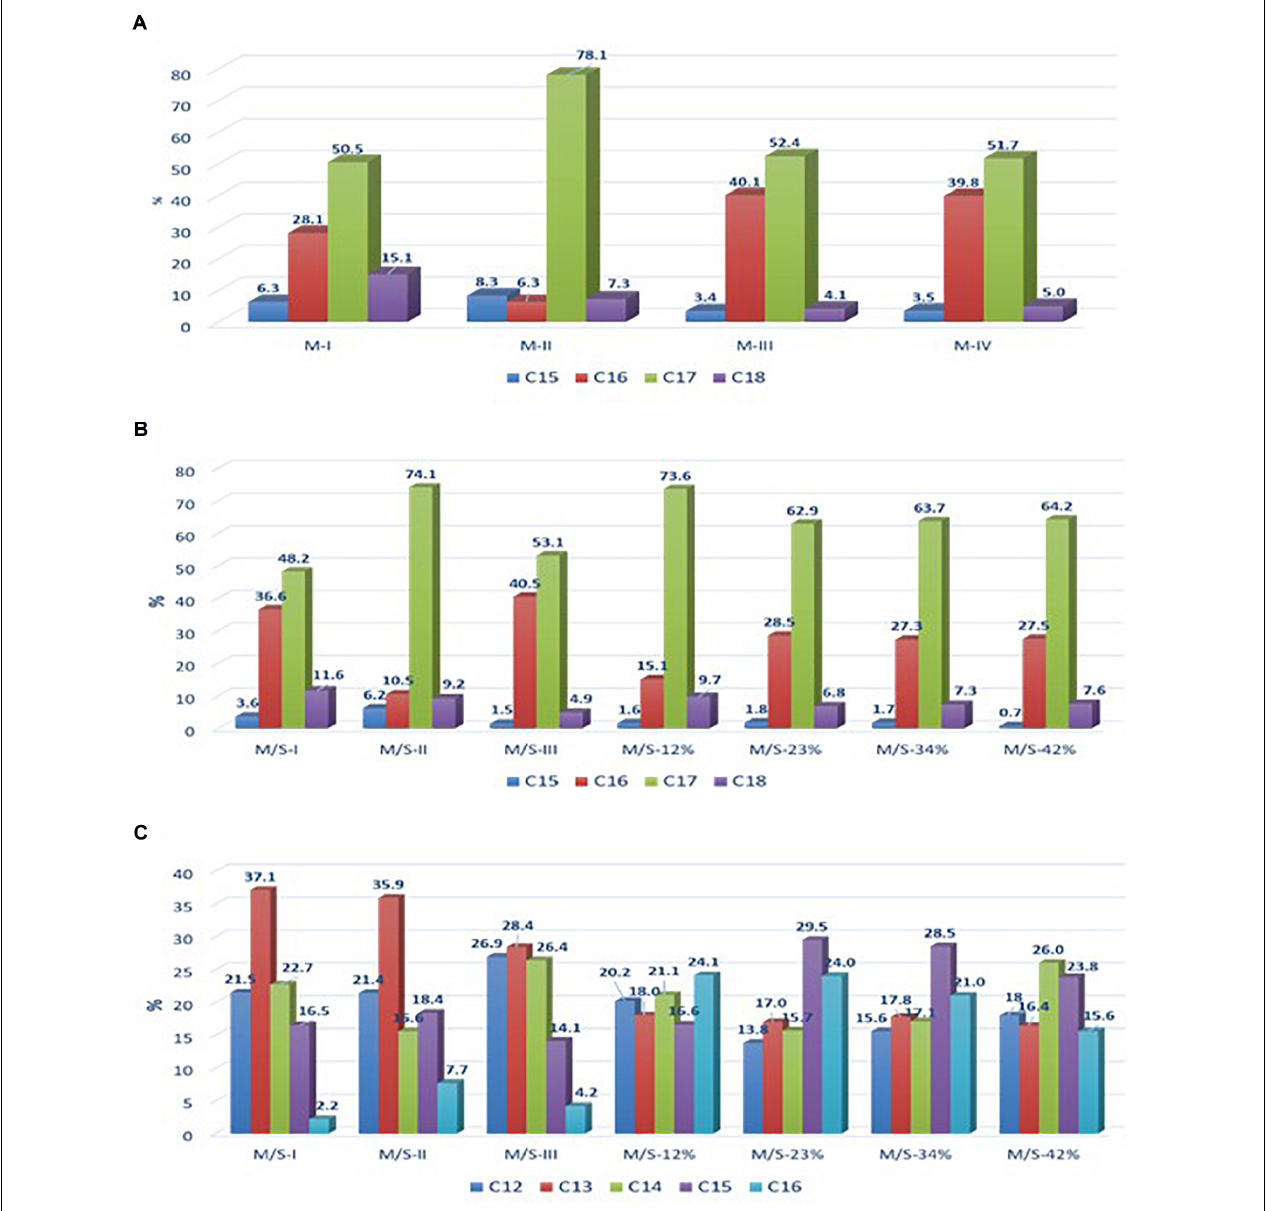
FIGURE 1 | Relative abundance of (A) mycosubtilin isoforms in different mycosubtilin samples, (B) of mycosubtilin isoforms, and (C) surfactin isoforms in different M/S samples.